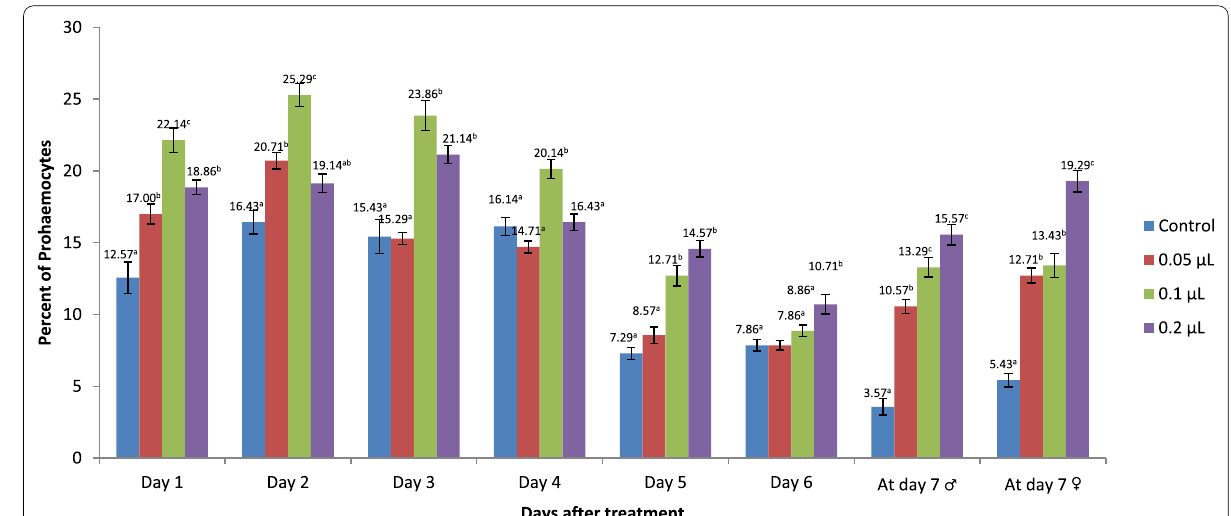
Fig. 2 Effect of Farnesol on Prohaemocytes of fifth instar nymphs of Dysdercus koenigii. Each bar represents Mean for calculation of mean Bars on a specific day after treatment with different letter are significantly different ( p < 0.05), computed by one-way ANOVA followed by Tukey’s all pairwise multiple comparison